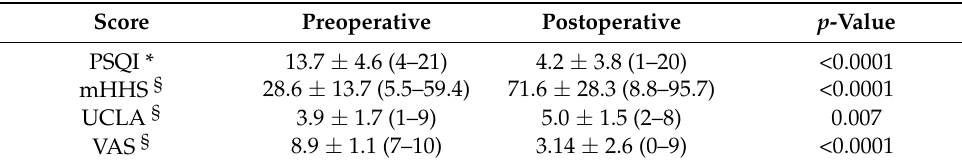
Table 3. Pre- and Post-operative Patient-Reported